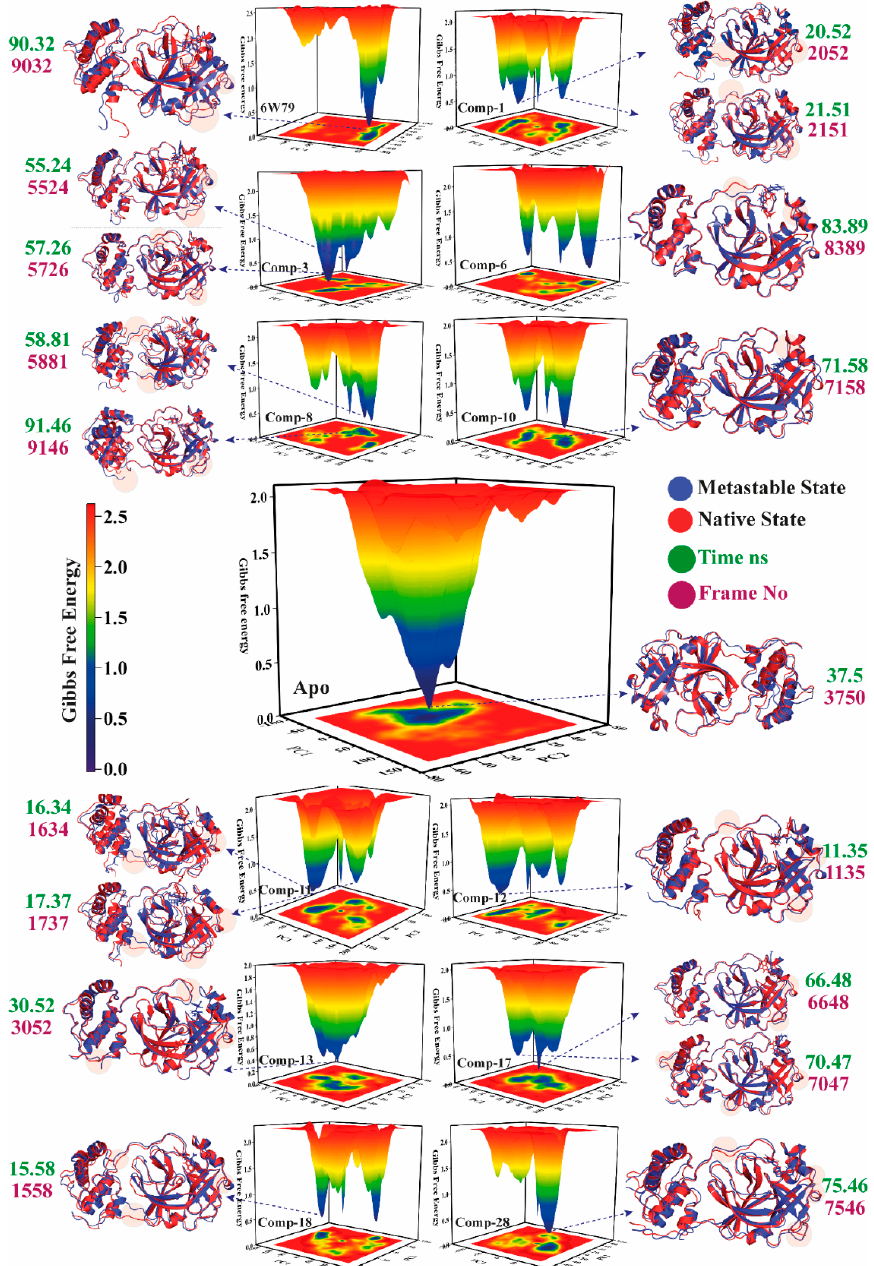
Figure 7. The free energy landscape (FEL) of free state and inhibited states is shown. High and low energy states are shown in distinct colors in the plot. The minimal, intermediate, and the high energy states are presented in dark blue, yellow, and red, respectively. The time of the metastable states (ns) and frame number is presented in green and purple, respectively. The metastable states and the native structures of M pro are depicted in cartoon model in blue and red,